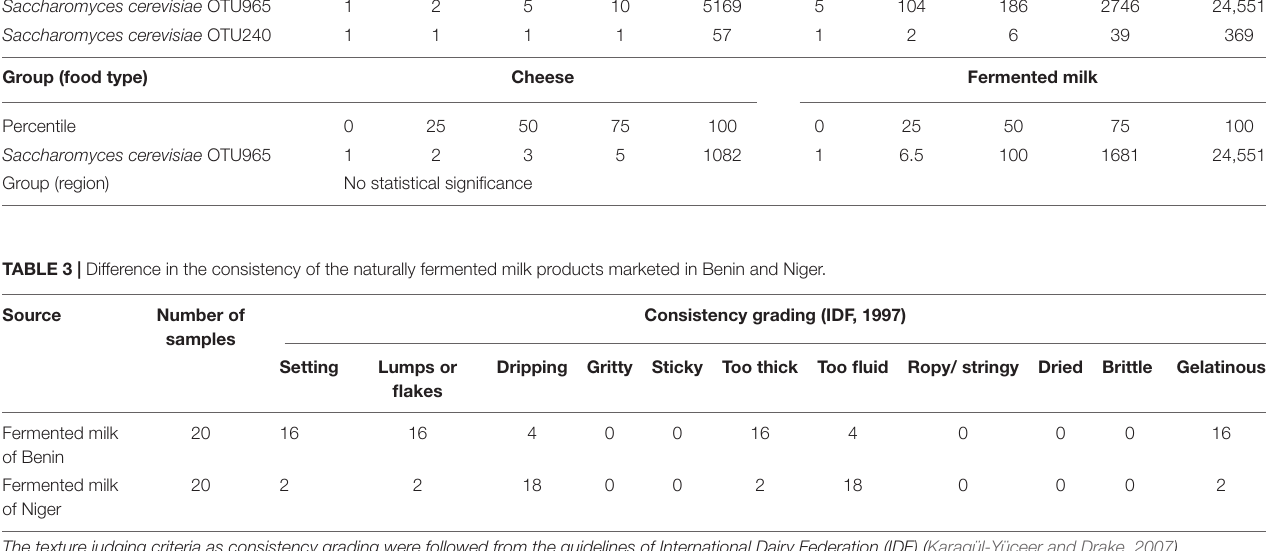
TABLE 2 | ANCOM differential abundance testing resulted significantly differing yeast taxa and their percentile abundance of samples by group. Group (country) Benin Niger Percentile 0